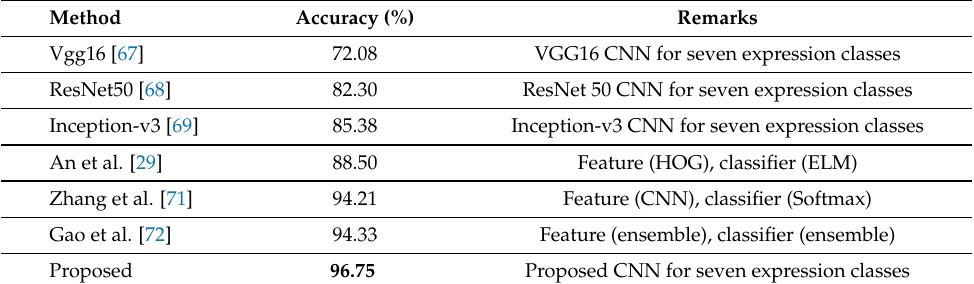
Table 8. Performance comparison of the proposed FERS for the GENKI